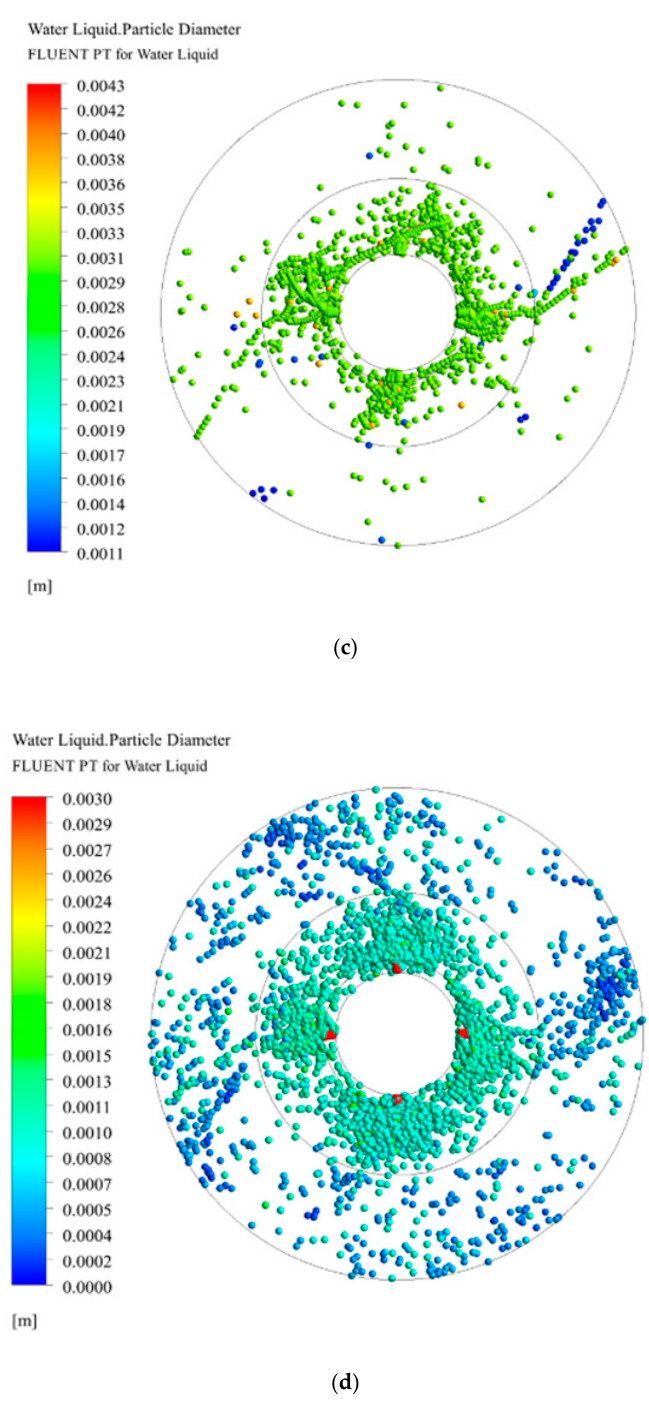
Figure 15. Droplet diameter under various initial droplet velocities and rotating speeds. ( a ) u 0 = 0.5 m / s, ω = 600 rpm; ( b ) u = 2.5 m / s, ω = 600 rpm; ( c ) u = 1.5 m / s, ω = 300 rpm; ( d ) u = 1.5 m / s, ω = 900 rpm.